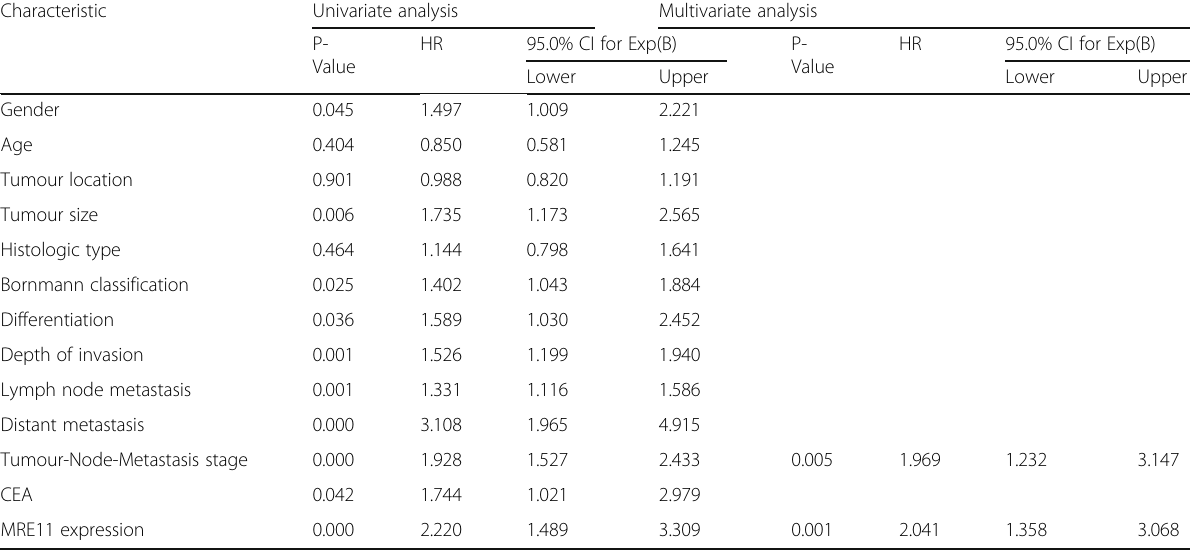
Table 4 Cox proportional-hazard regression analysis for Recurrence Free Survival Characteristic